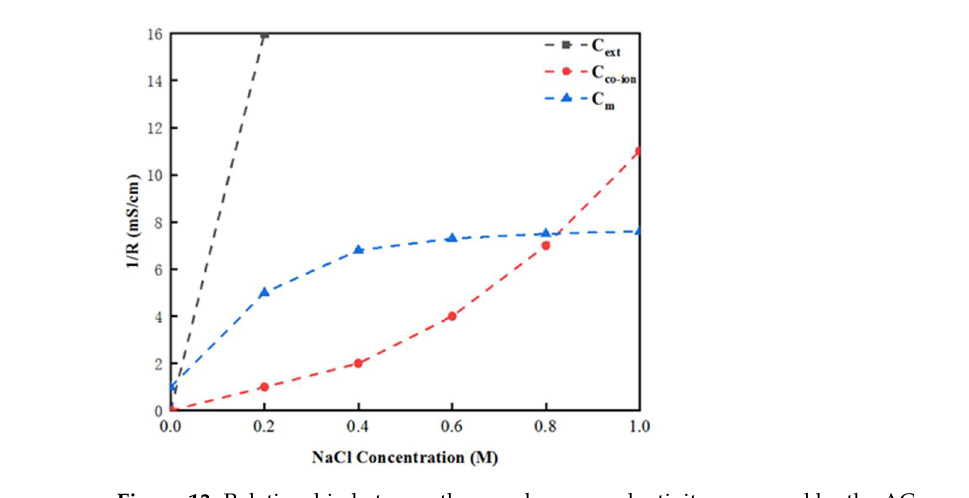
Figure 13. Relationship between the membrane conductivity measured by the AC approach, internal and external solution conductivity, and the concentration of the external salt solution.